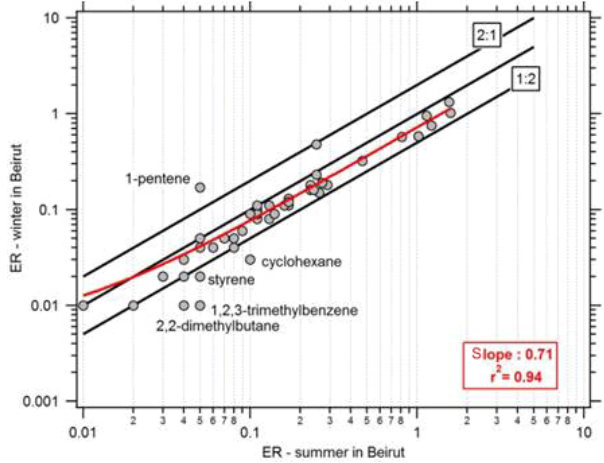
Figure 5. Comparison of the emission ratio (ER) estimated relative to acetylene using the night-time linear regression fit and the photo- chemical age fit in summer.